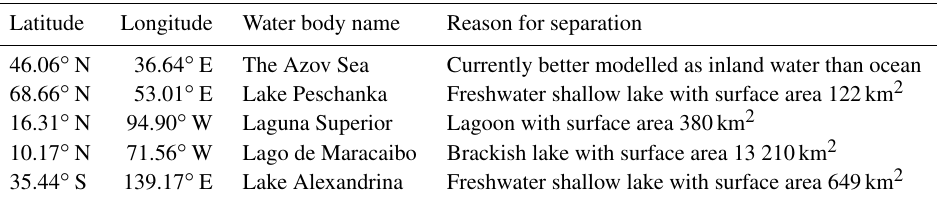
Table 2. List of the exceptional water bodies for manual separation from the ocean.